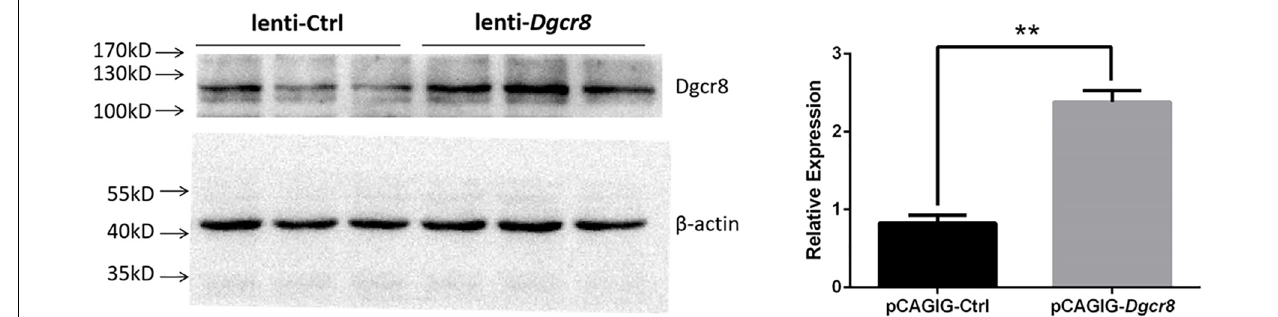
FIGURE 2 | Dgcr8 was overexpressed in hippocampus of case group. Lenti-Ctrl or lenti- Dgcr8 was injected into dentate gyrus of hippocampus. Two weeks later, extracts from hippocampus were immunoblotted with Dgcr8 antibody (ProteinTech Group, 10996-1-AP). Protein levels were normalized to β -actin, presented as means ± SEM. N = 3 for lenti-Ctrl and lenti- Dgcr8 , respectively. One-way ANOVA test. ** p = 0.0035.